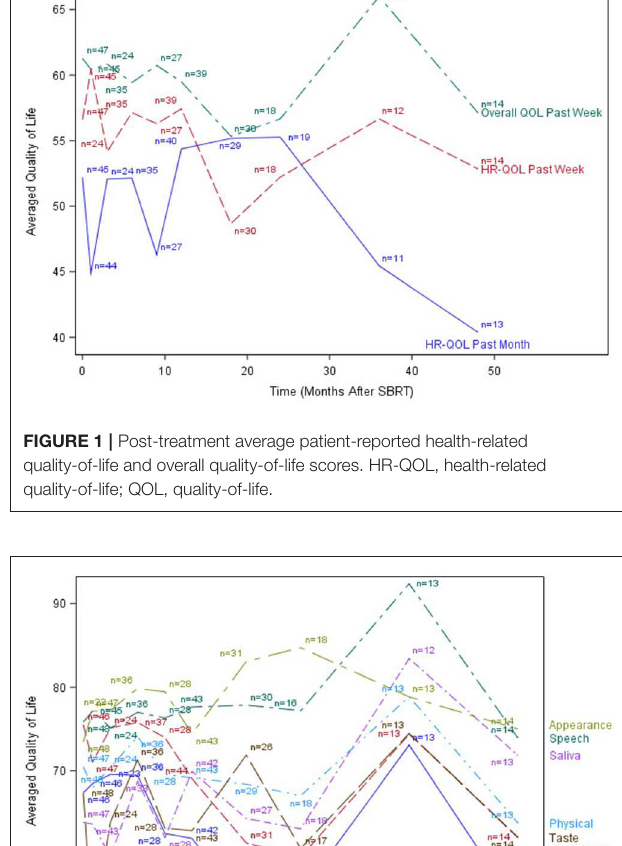
TABLE 1 | Patient and treatment characteristics.